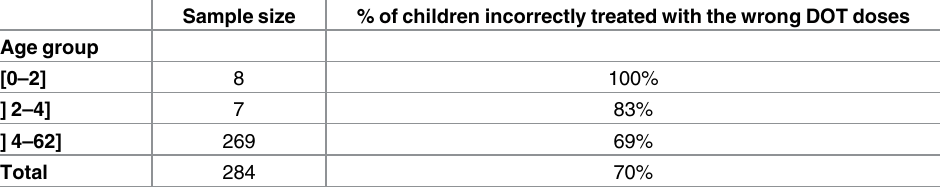
Table 1. Percentage of children in a given age group treated with the wrong number of DOT doses during the 2015 campaign, according to the SMC card and parental report. Sample